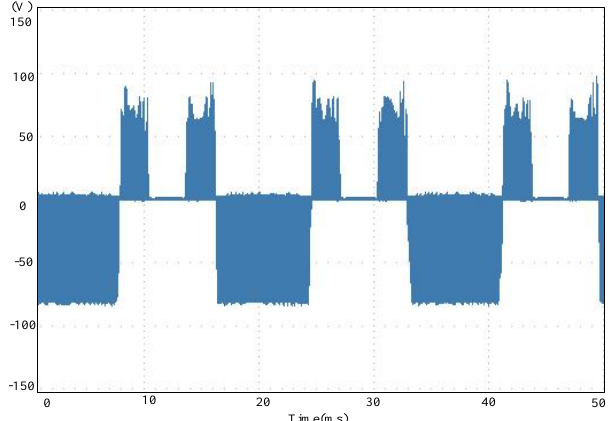
Figure 8. Waveform of the c -phase output voltage ( v co ) of the inverter at a working frequency of Figure 8. Waveform of the c − phase output voltage ( v co ) of the inverter at a working frequency of 60 Figure 8. Waveform of the c − phase output voltage ( v co ) of the inverter at a working frequency of 60 Figure 8. Waveform of the c − phase output voltage ( v co ) of the inverter at a working frequency of 60 60 Hz with a fault in switch S c 1 + Hz with a fault in switch S c 1+ . Hz with a fault in switch S c 1+ . Hz with a fault in switch S c 1 + .